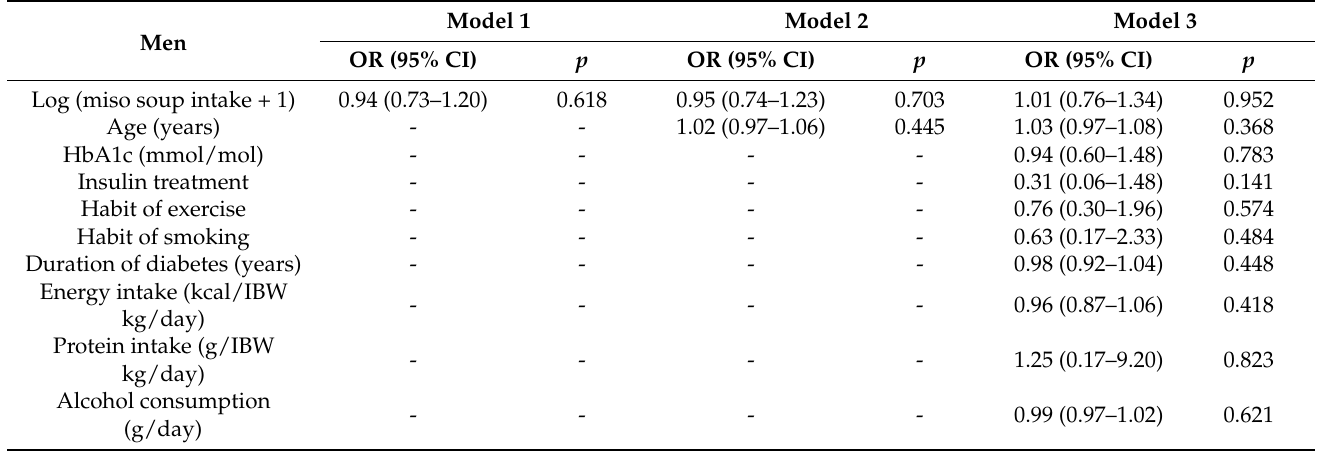
Table 6. Odds ratio of the quantity of miso soup intake on the presence of